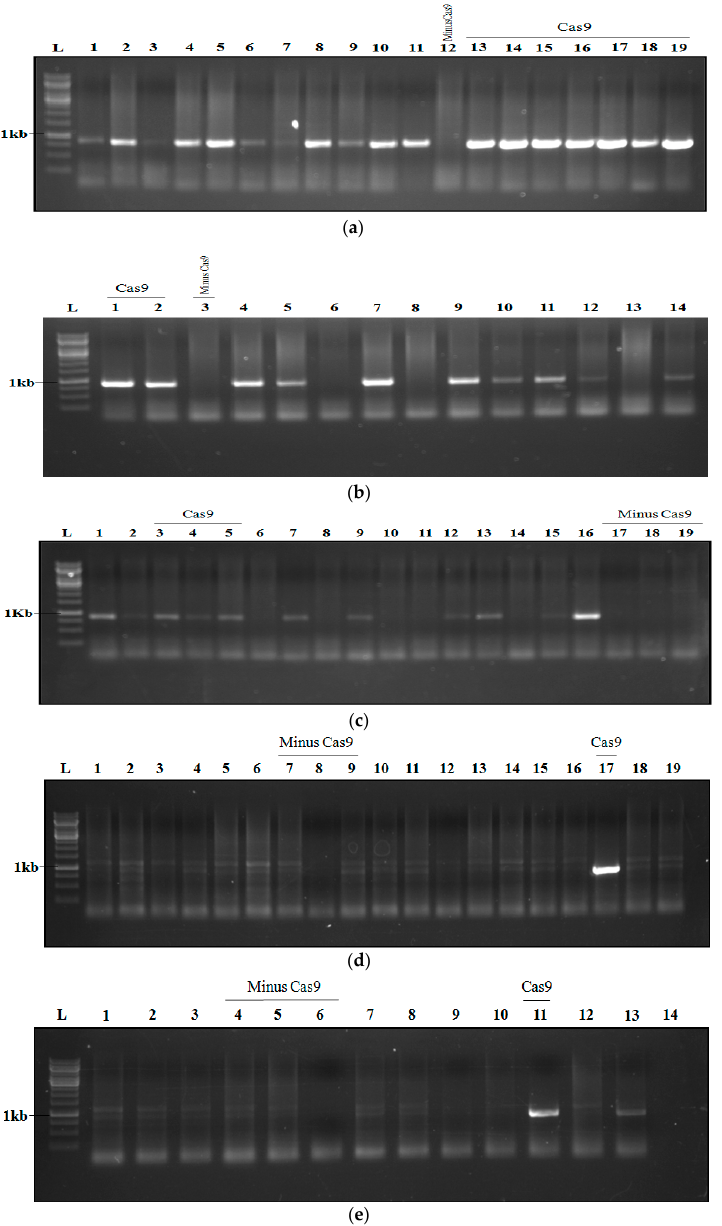
Figure 8. The confirmation of Cas9-free plant lines in the laboratory using the PCR technique employing isolated DNA from mutant plants and control plants. L band is 1 kb DNA ladder. ( a – c ) We selected 31 Cas9-free plants from 120 edited plants lines with conformation Cas9 primers for Cas9-free knockout plants lines of SSSII-1, 2, and 3 genes. ( d,e ) The final confirmation of selected Cas9-free mutant lines with Cas9 primers.